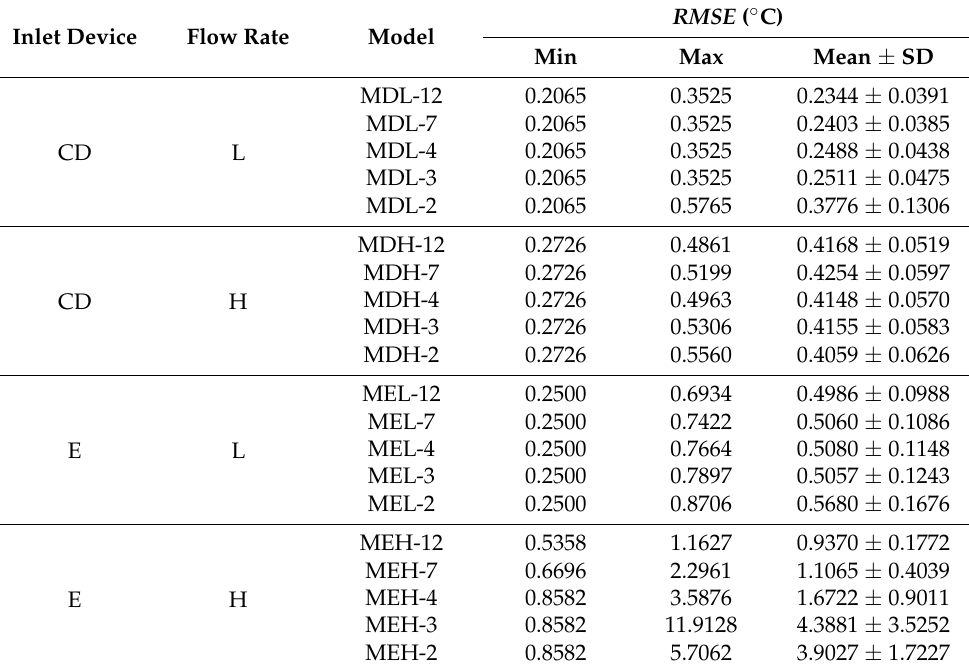
Table 3. RMSE ( ◦ C) values obtained for each model in the estimation of the temperature evolution at the 12 TC